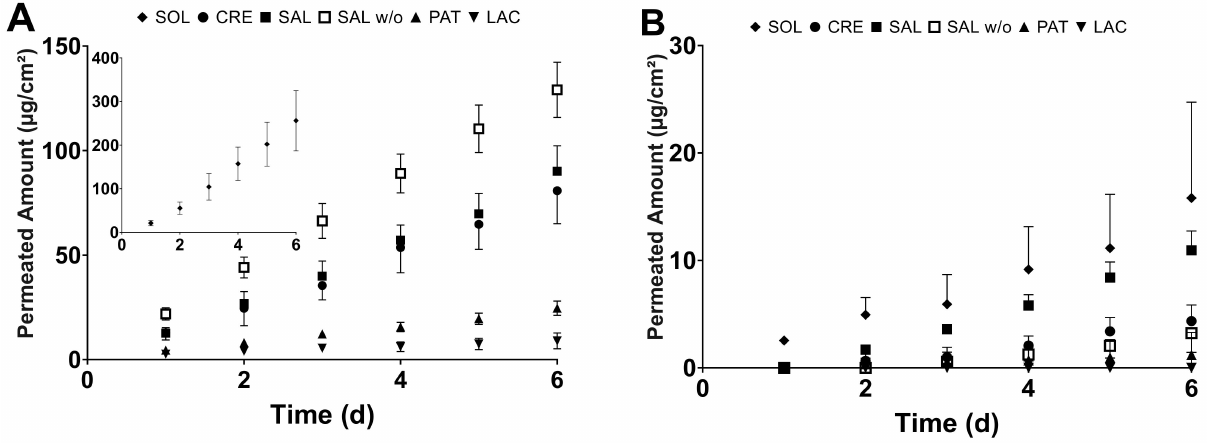
Figure 5. Permeation of bifonazole (BFZ) out of the solution (SOL), Canesten ® Extra Creme (CRE), Canesten ® Extra Salbe (SAL), Canesten ® Extra Salbe without urea (SAL w / o ), patch (PAT) and lacquer (LAC) across ( A ) 100- µ m and ( B ) 400- µ m healthy bovine hoof sheets (mean ±